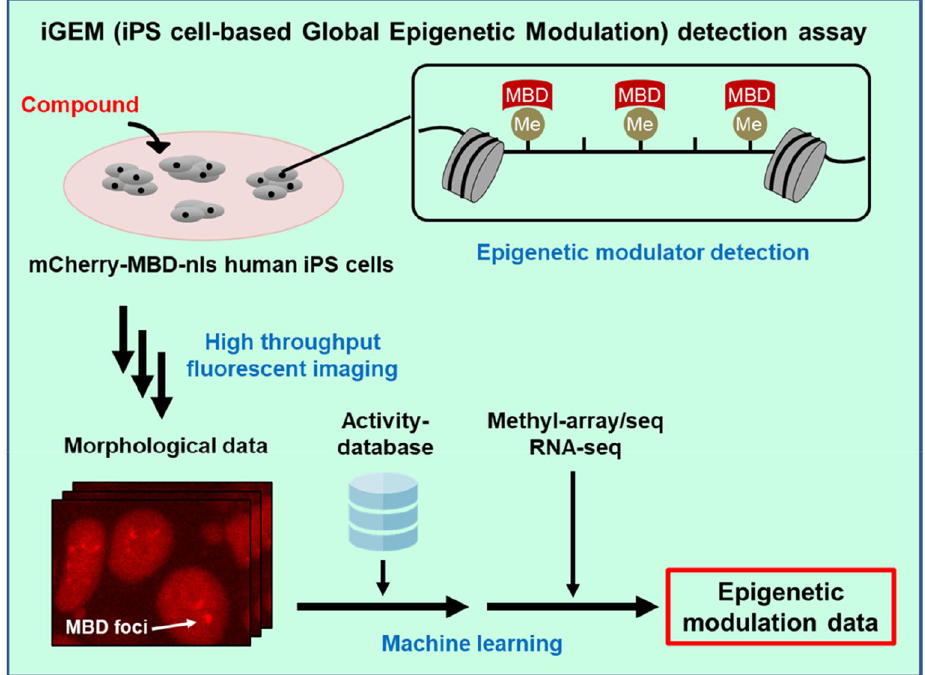
Figure 7. Schematic overview of iPS cell-based global epigenetic modulation (iGEM) detection